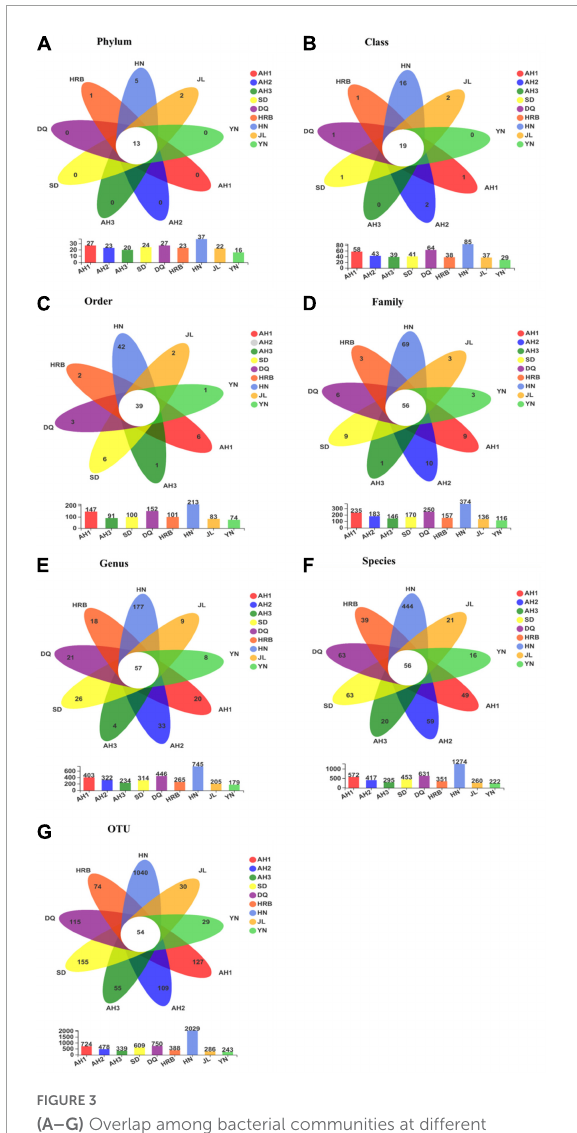
FIGURE3 (A–G) Overlap among bacterial communities at different taxonomic levels among the nine geographic populations of the hemp flea beetle P. attenuata in China, with the number of species unique to each population in the petal and the number of species common to all populations in the center. Below is a bar chart of the total number of species in each population at selected taxonomic level.